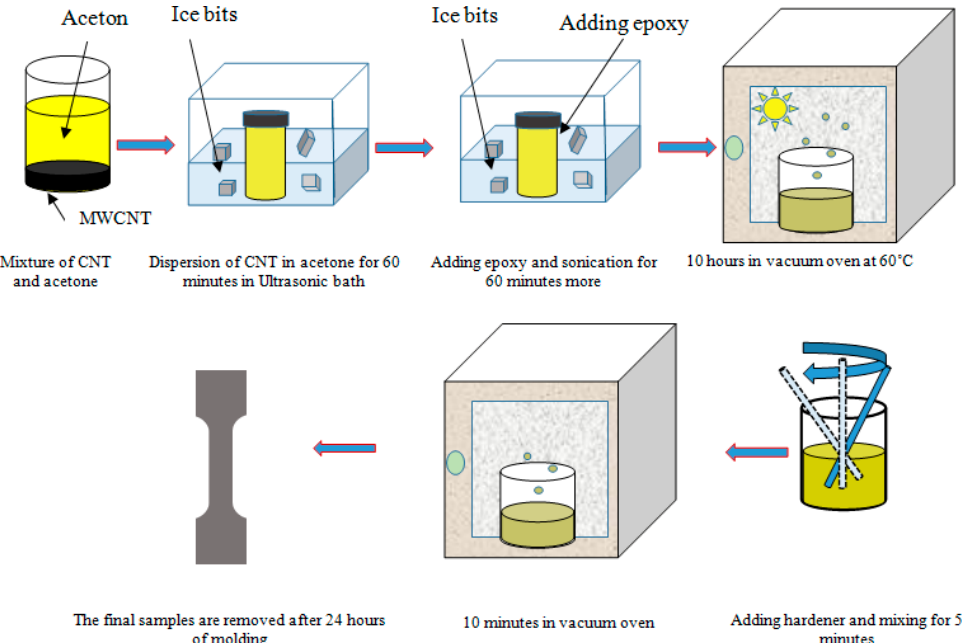
Figure 15. The production stages of CNT/epoxy nanocomposite. Nanomaterials 2018 , 8 , x FOR PEER REVIEW